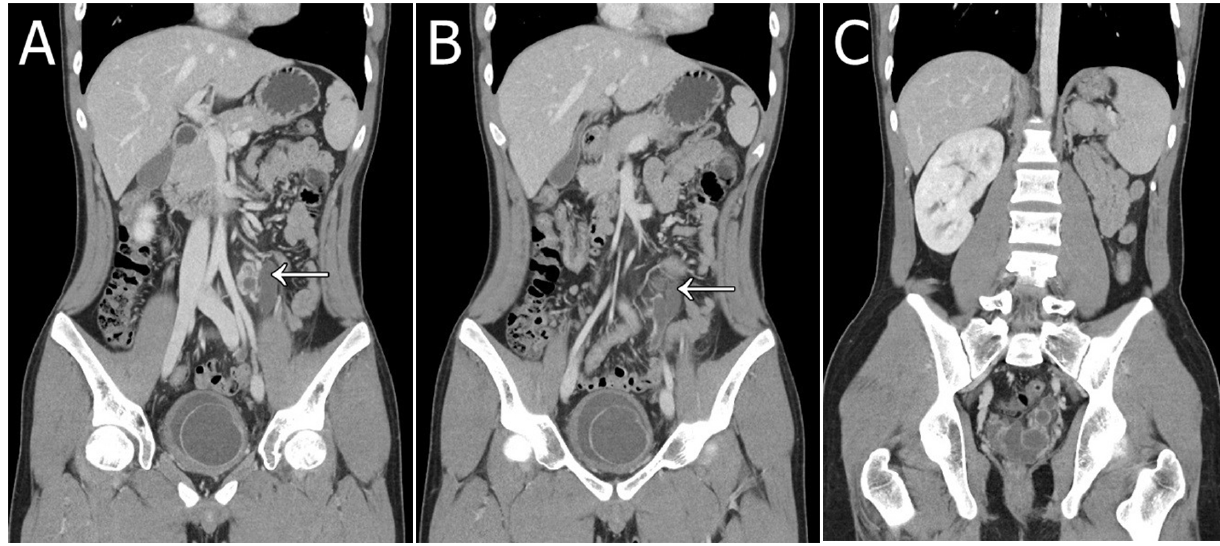
Fig. 1. Preoperative computed tomography . (A,B) A megaureter, duplicated ureter and blind-ended proximal ureter accompanying the left atrophied kidney. (C) The right kidney showed compensatory hypertrophy.